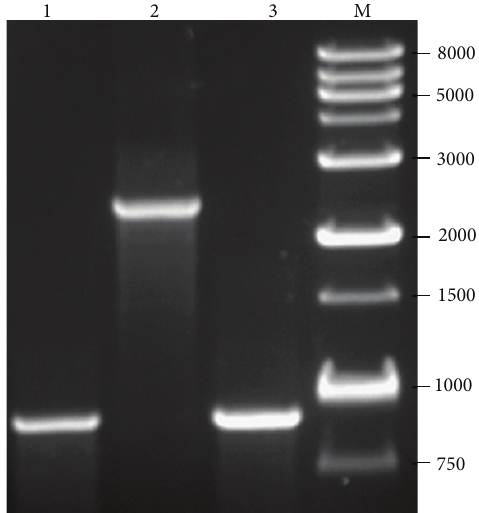
Figure 1: PCR verification of a mutation in the SaNOS gene in S. aureus . Primers P7 (5 󸀠 -ATACAGAAGAAGAACTTATTTATGG-3 󸀠